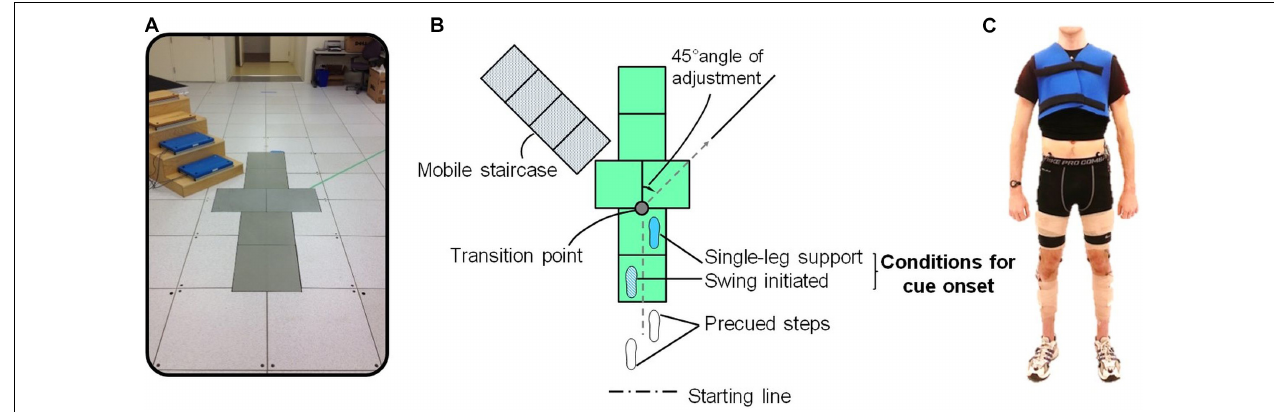
FIGURE 2 | Experimental setup for locomotor tasks. (A) Lab setup for level-ground walking, sidestep and crossover cuts, and cut-to-stair-ascent locomotion. A custom built 4-step staircase was used for the tasks with the stair conditions with risers and treads of dimension 7.5 in and 12 in, respectively. For ascent and descent conditions, the length of the walkway preceding the staircase was 6.2 m and 5.2 m, respectively. (B) Subjects enter a locomotor transition at single leg support. The transition point and path for cut transitions were shown on the walkway. (C) Forty-two reflective markers including four clusters of markers connected via thermoplastic shells were placed on trunk, pelvis, and legs. Kinematic marker data were measured at 120 Hz using a 10-camera motion capture system (Motion Lab Systems, Inc.). Cameras were placed circumferentially along the wall of the motion capture lab, which was roughly 1,000 ft 2 in